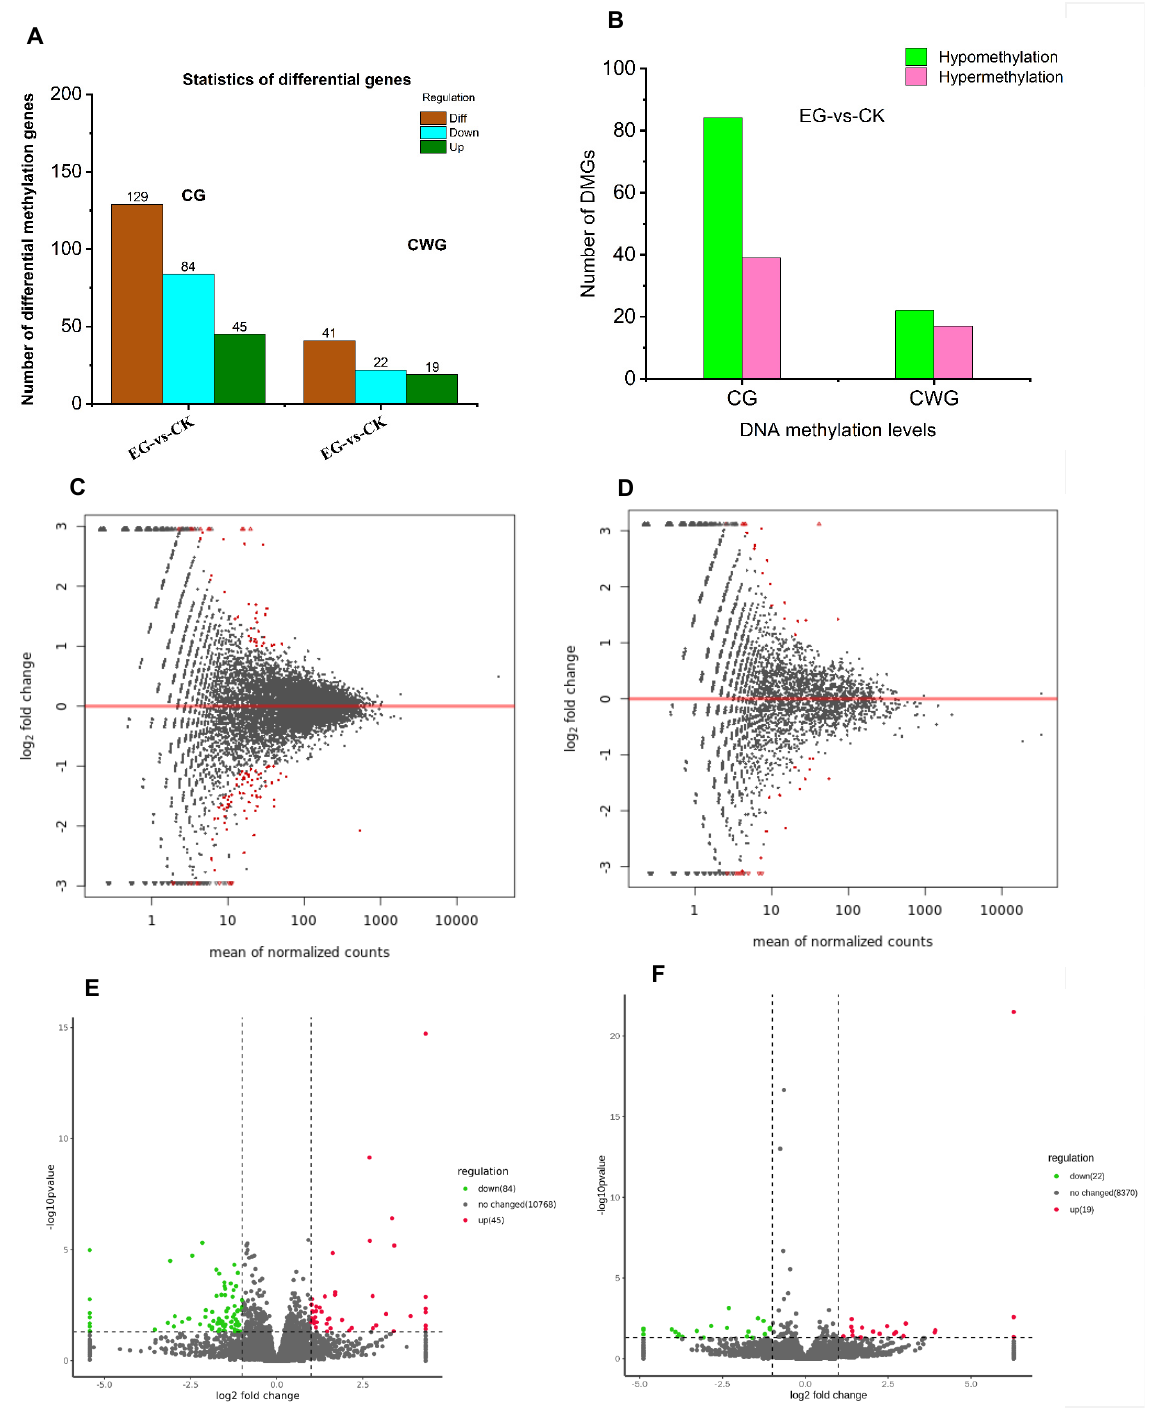
Figure 7. Differential methylation gene at CG and CWG level between EG-vs.-CK. ( A ) The number of differential methylated genes in CG and CWG sites; ( B ) the number of hypo/hypermethylated genes in the CG and CWG sites; ( C , D ) MA plot of DMGs in CG and CWG sites; ( E , F ) volcano plot of the DMGs in CG and CWG sites. The small red circle represents upregulated DMS. The blue and dark grey color means the downregulated DMS and non-significant methylated